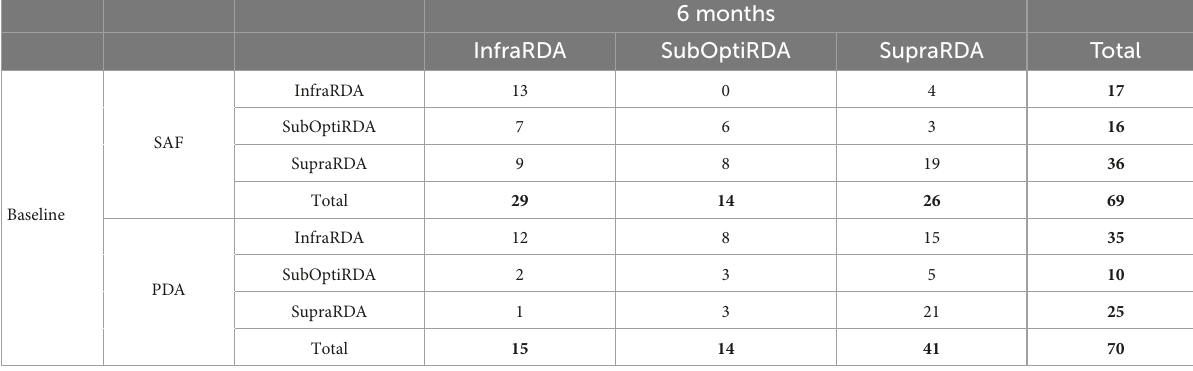
TABLE 4 Evolution of baseline population distribution in the classes after 6 months (number of